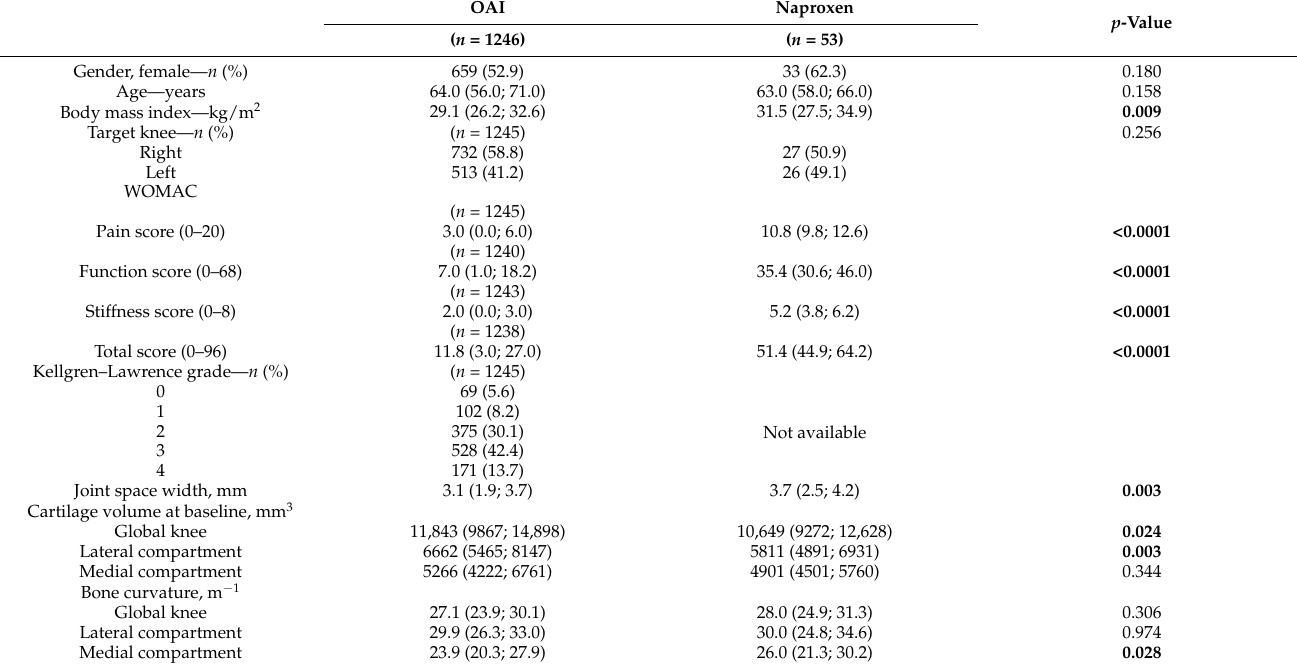
Table 1. Baseline participant